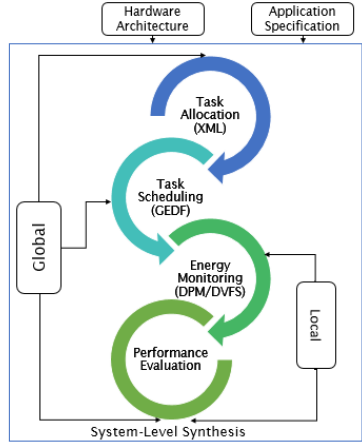
Figure 3. HEEPS Phases Integration.